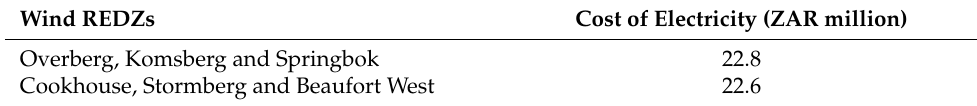
Table 9. Annual cost of electricity (only G-ES considered).